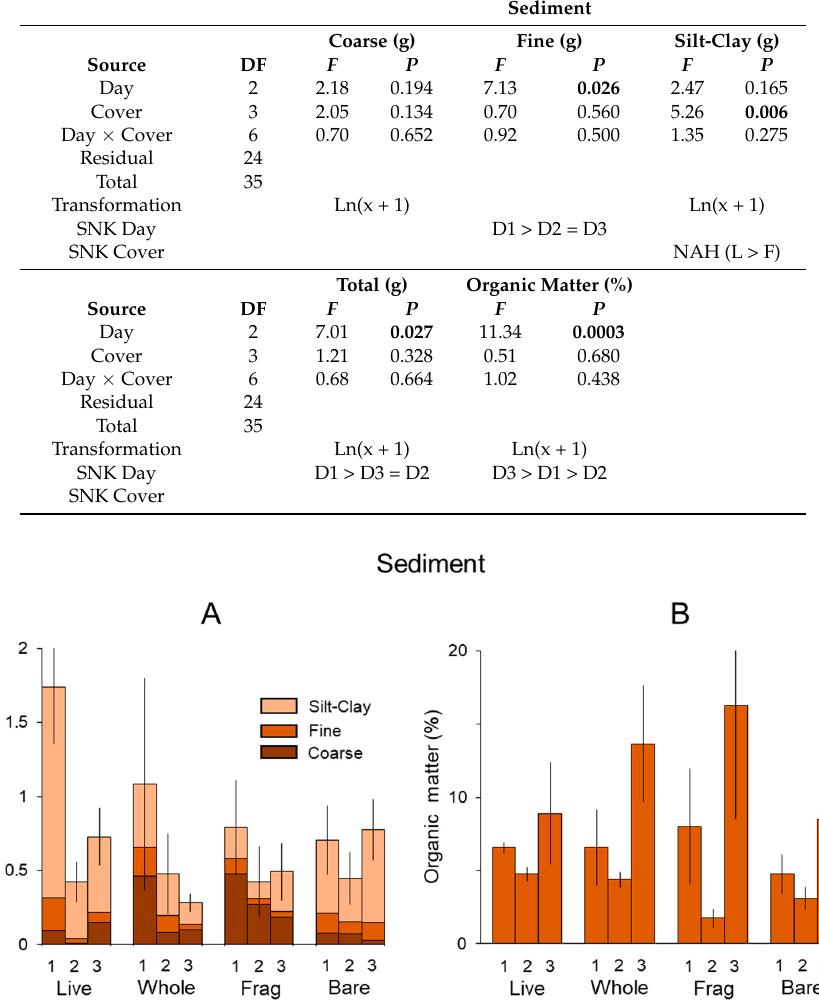
Figure 3. ( A ) Mass values of silt-clay, fine sand, and coarse material in traps. For clarity, error bars are presented only for total sediment mass. ( B ) Percent organic matter. Values are mean ± 1 SE. Live = live mussels, Whole = whole shells, Frag = fragmented shells, Bare = bare sediment. 1 = Day 1, 2 = Day 2, 3 = Day 3. Table 1. ANOVA results for sediment in traps: mass values and percent total organic material. Transformations indicated where applied. Significant differences ( P < 0.05) are in bold and Student- Newman-Keuls (SNK) results are presented. NAH = no alternative hypothesis; the two groups with the largest and smallest means within the factor were significantly different, and no further resolution among the groups in that factor could be determined. L = live mussels, F = fragmented shells. D1 = Day 1, D2 = Day 2, D3 = Day 3.